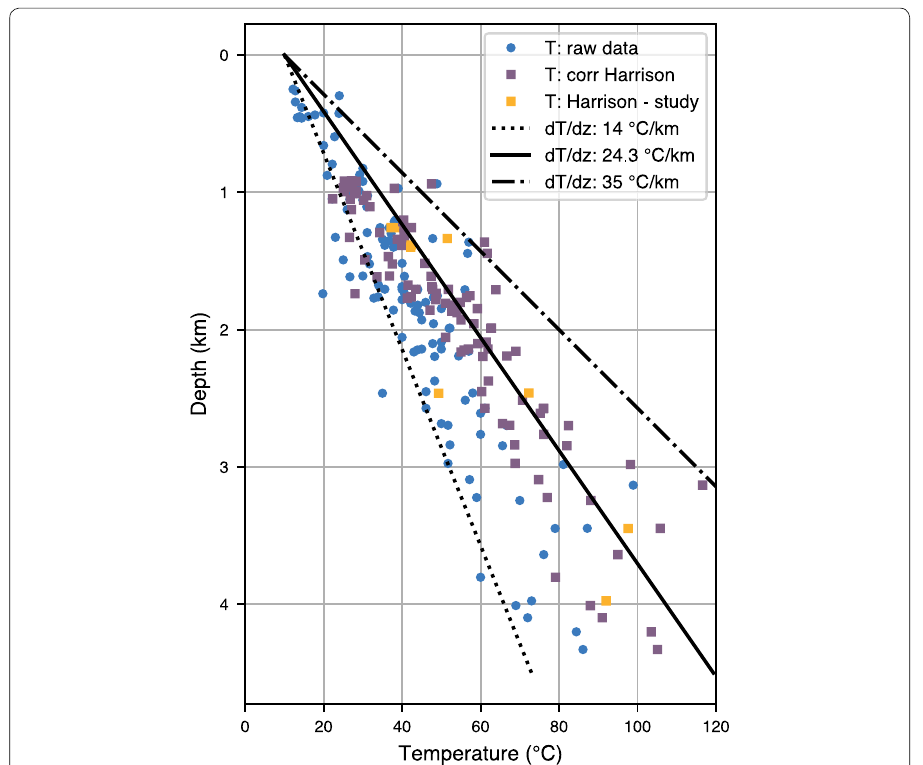
Fig. 6 Temperature–depth relationship. Temperature–depth relationship based on 124 bottom hole temperature data (Bédard et al. 2016) from petroleum wells located in the St. Lawrence Lowlands. The yellow squares are the temperature data after Harrison correction in the modeled region of this